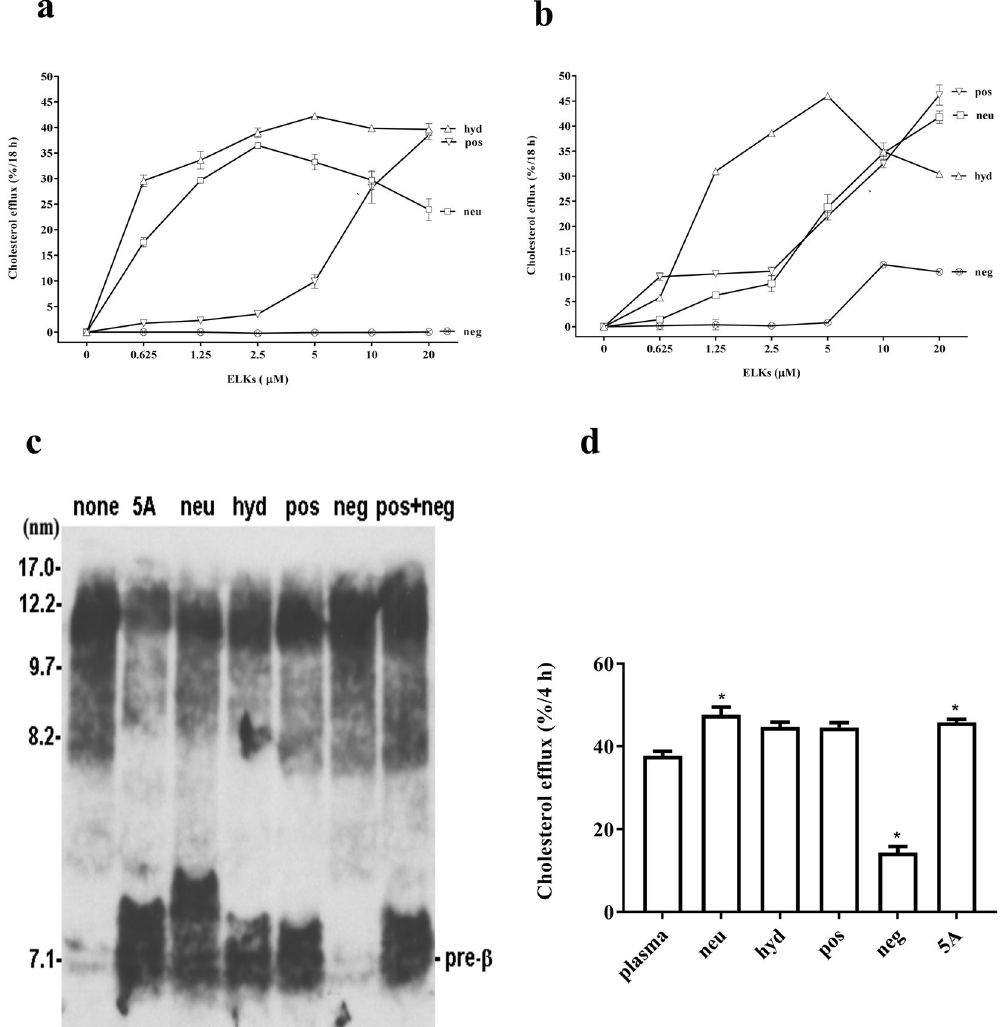
Figure 5. Efflux assay of ELKs. ( a ) Cholesterol efflux from ABCA1-BHK cells as a function of peptide concentration. ( b ) Cholesterol efflux from ABCA1 transporter induced in macrophages as a function of peptide concentration. Results are expressed as the mean ± 1 S.D. of triplicates in ( a ) and ( b ). A positive control using 0.5 µ M apoA-I protein showed 30% ( a ) and 26% ( b ) efflux after 18 h. ( c ) Human plasma incubation of ELKs causes HDL remodeling. ( d ) Cholesterol efflux by ABCA1 transporter-expressing cells treated with human pooled plasma pre-treated with ELKs. A previously described apoA-I mimetic peptide, 5A, was included as a positive control ( c ) and ( d ). Statistical analysis was performed comparing each peptide with control sample (plasma alone) using paired t test and presented as p < 0.05 = * .